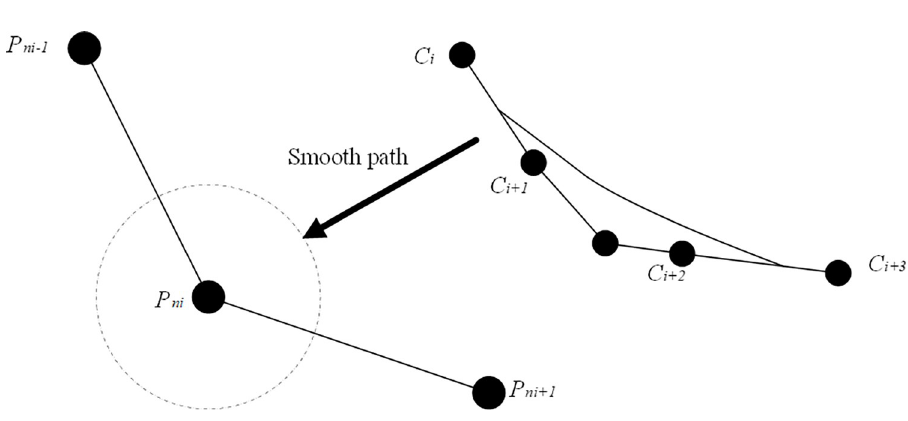
Fig 3. Smooth path